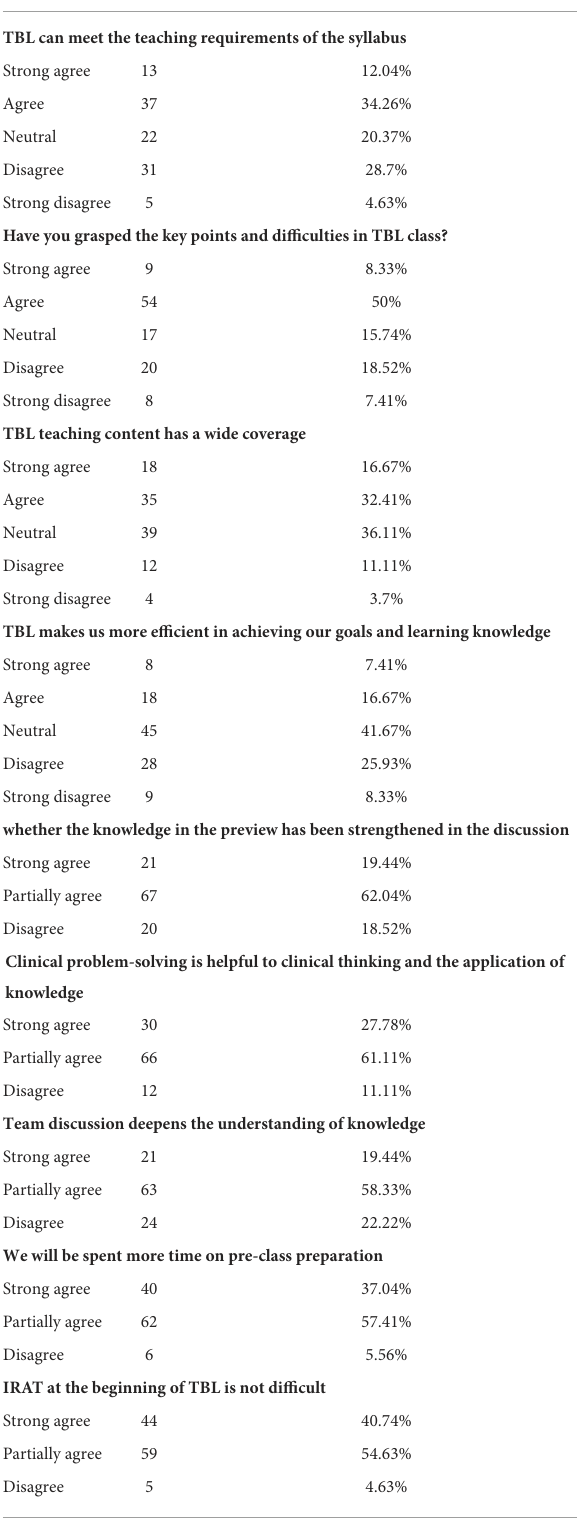
TABLE 1 Questionnaire results about the teaching objectives among team-based learning (TBL)